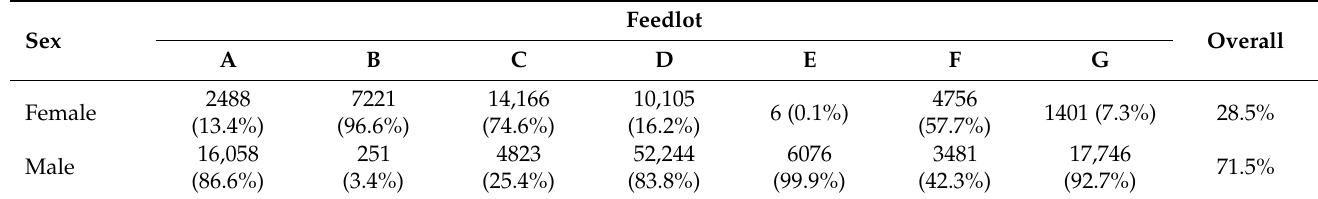
Table 7. Distribution of female and male cattle across the seven feedlots during the